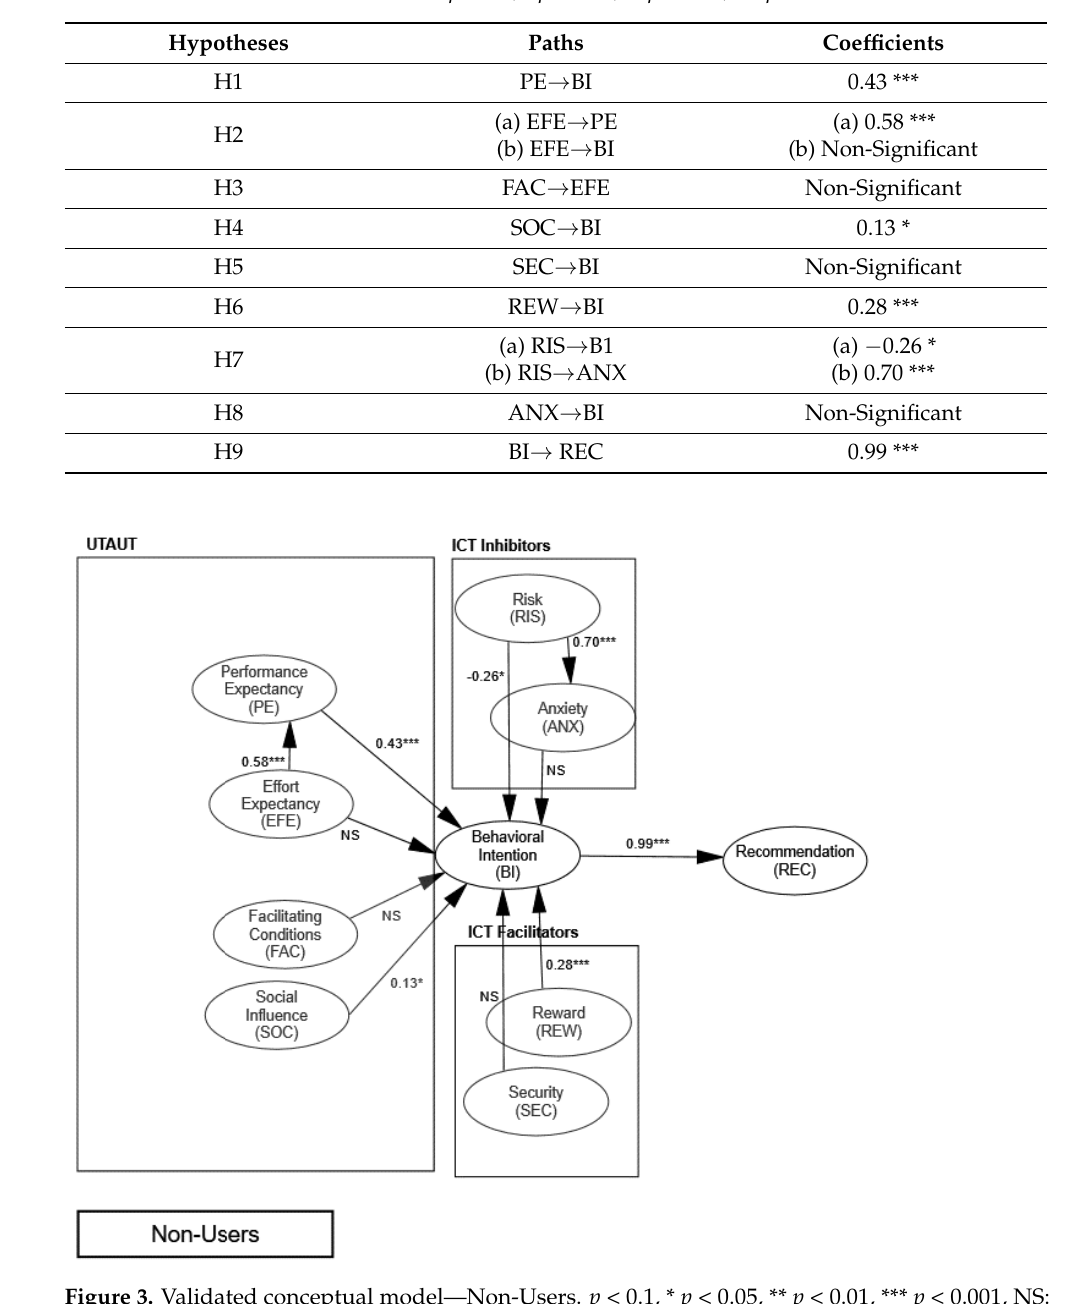
Table 9. Path coefficients—Non-users. p < 0.1, * p < 0.05, ** p < 0.01, *** p < 0.001.